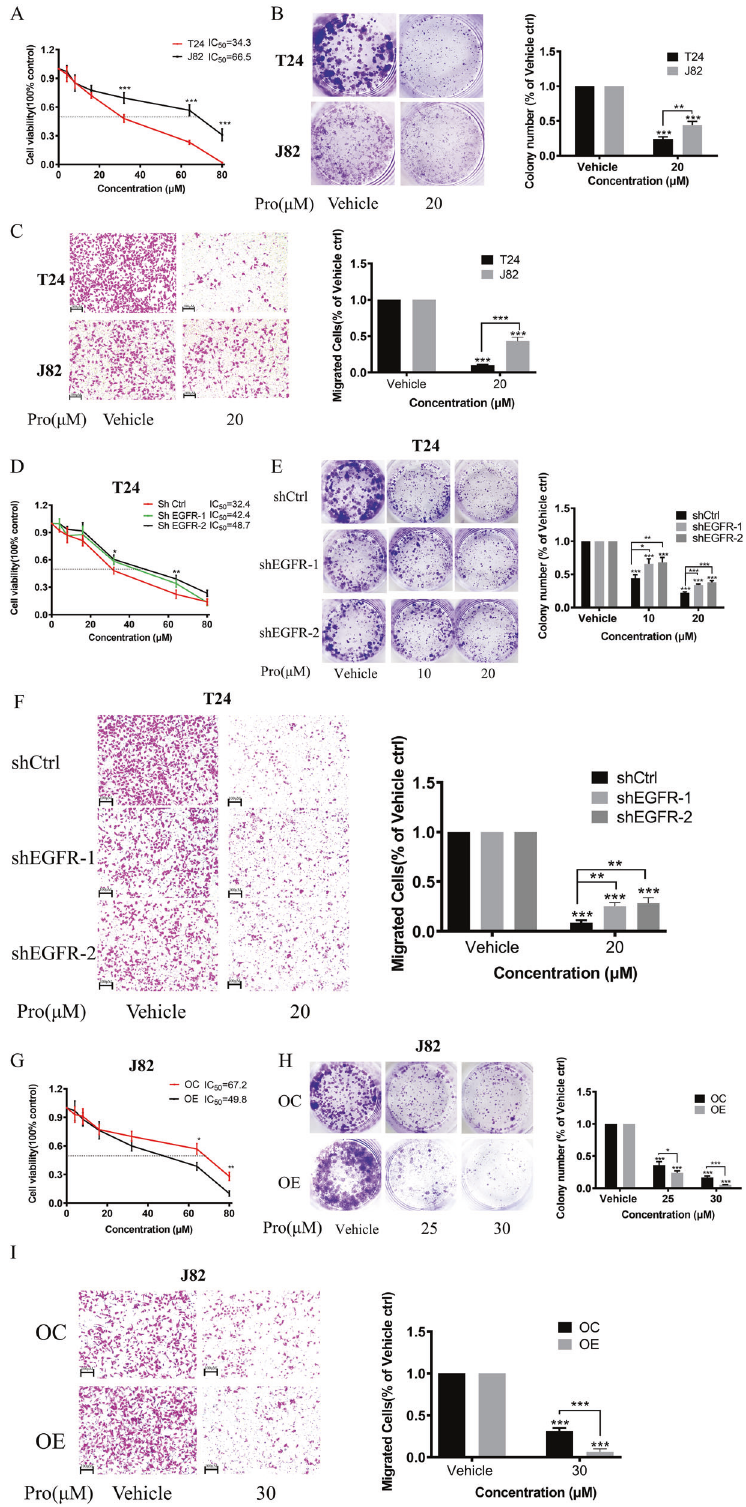
Fig. 3 The relationship of EGFR expression and the sensitivity of BC cells to proguanil. A – C The inhibitory effects of proguanil on proliferation and migration of T24 and J82 cell lines were compared by MTT, colony formation and transwell assay. D – F The inhibitory effects of proguanil on proliferation and migration of shCtrl, shEGFR-1 and shEGFR-2 cell lines were compared by MTT, colony formation and transwell assay. G – I The inhibitory effects of proguanil on proliferation and migration of OC-J82 and OE-J82 were compared by MTT, colony formation and transwell assay. See “ Materials and methods ” for more experimental details. Data are representative of three independent experiments. Error bars represent means ± SD from triplicate experiments. Vehicle control means the concentration of DMSO lower than 0.3% (* P < 0.05, ** P < 0.01, *** P <